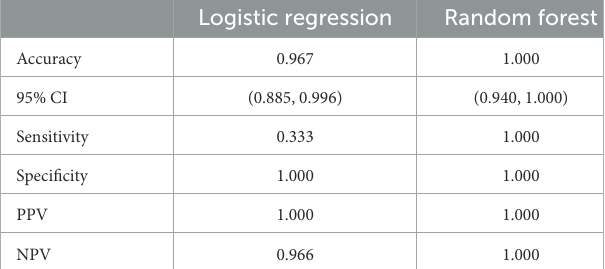
TABLE 3 Basic comparison between two prediction